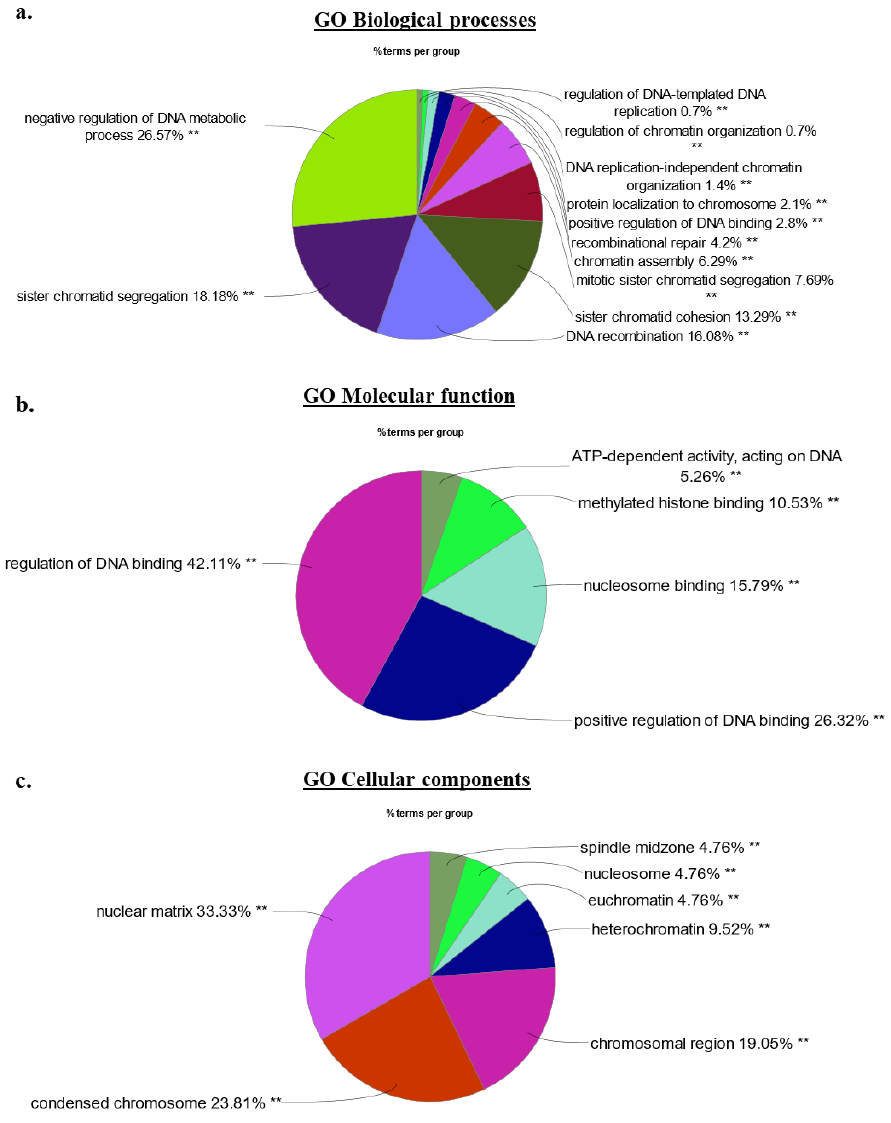
Figure 5. ( a – c ) Gene ontology analysis of the 62 top candidate proteins identified in the HMGA2- BioID2 and -miniTurbo biotin proximity assays. Nuclear chromatin- and nucleosome associated processes and functions constitute the main GO terms associated with the top 62 HMGA2 nuclear in- teraction candidates identified by biotin proximity labeling in unchallenged HEK293 cells. Percentage distribution of major ( a ) GO–Biological processes, ( b ) GO–Molecular functions, and ( c ) GO–Cellular components, as determined by Cytoscape version 3.8 and ClueGo v2.5.9. Adjusted p -values considered statistically significant as denoted by ** p < 0.001.